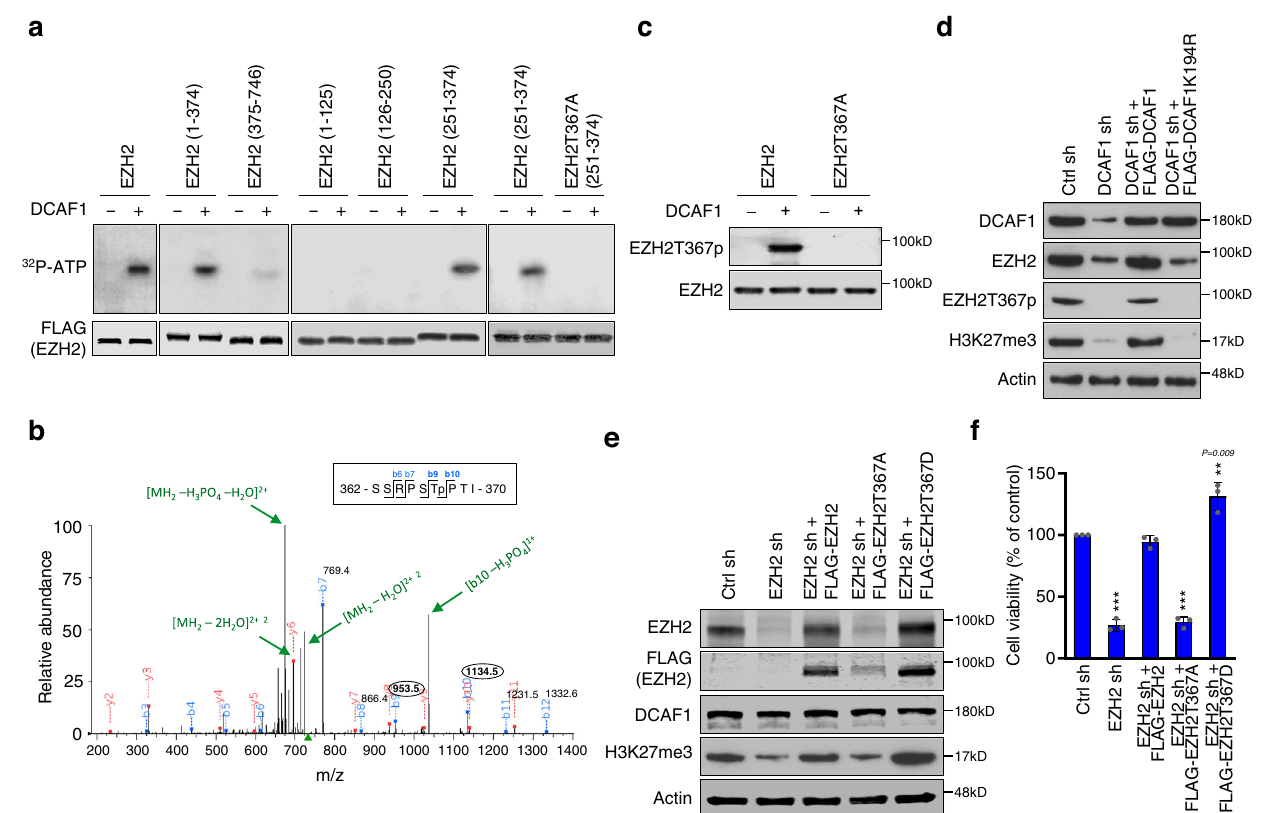
Fig.2|PhosphorylationofEZH2atT367byDCAF1.a Theindicatedrecombinant EZH2proteinswereincubatedwithDCAF1inthepresenceof[ γ - 32 P]ATPfor30min. The reactions were then resolved on 5 – 20% SDS-PAGE and analyzed by auto- radiography (upperpanel)and Westernblot (lowerpanel).Data are representative of three independent experiments. b EZH2 251-374 wasphosphorylated by DCAF1, digested with trypsin, and analyzed by liquid chromatography-tandem mass spectrometry (LC-MS/MS) identifying the presence of phosphorylated T367. c EZH2 wild type or T367A mutant proteins were modi fi ed by DCAF1 and analyzed by Western blot using the antibody raised against EZH2T367p. Data are repre- sentative of three independent experiments. (See also Supplementary Fig. 3). d DCAF1-depletedSW620 cells were infected with lentiviruses expressing 3×FLAG- DCAF1wildtypeandK194Rkinase-deadmutantasindicatedonthetop.Celllysates